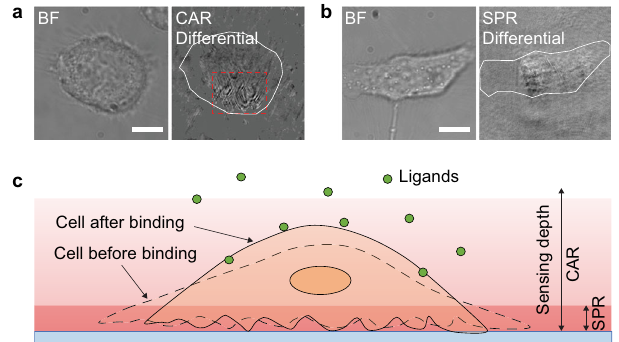
Fig. 6 Sensing depth of CAR and SPR. a Bright- fi eld (left) and differential CAR (right) images of a live single cell. The differential CAR image was obtained by subtracting two consecutive frames in an image sequence recorded at 10 frames per second. The white line marks the outline of the cell. The parabolic patterns within the cell (marked by the red square) are generated by the motion of organelles. See Supplementary Movie 3 for details. About 90% of the cells imaged with CAR showed such patterns. b Bright- fi eld (left) and differential SPR images of a live single cell. The images were captured and processed under the same condition as in a . Organelle motion was not revealed by SPR for the ~20 cells imaged. Scale bars in a and b represent 10 µ m. c Schematic picture showing sensing a cell with CAR and SPR. SPR senses the sample with the surface-con fi ned evanescent fi eld and only the bottom section of the sample (several hundred nanometers) can be imaged. CAR has a portion of transmitted light additional to the much deeper evanescent fi eld, which enables CAR to detect the binding-induced deformation of the whole